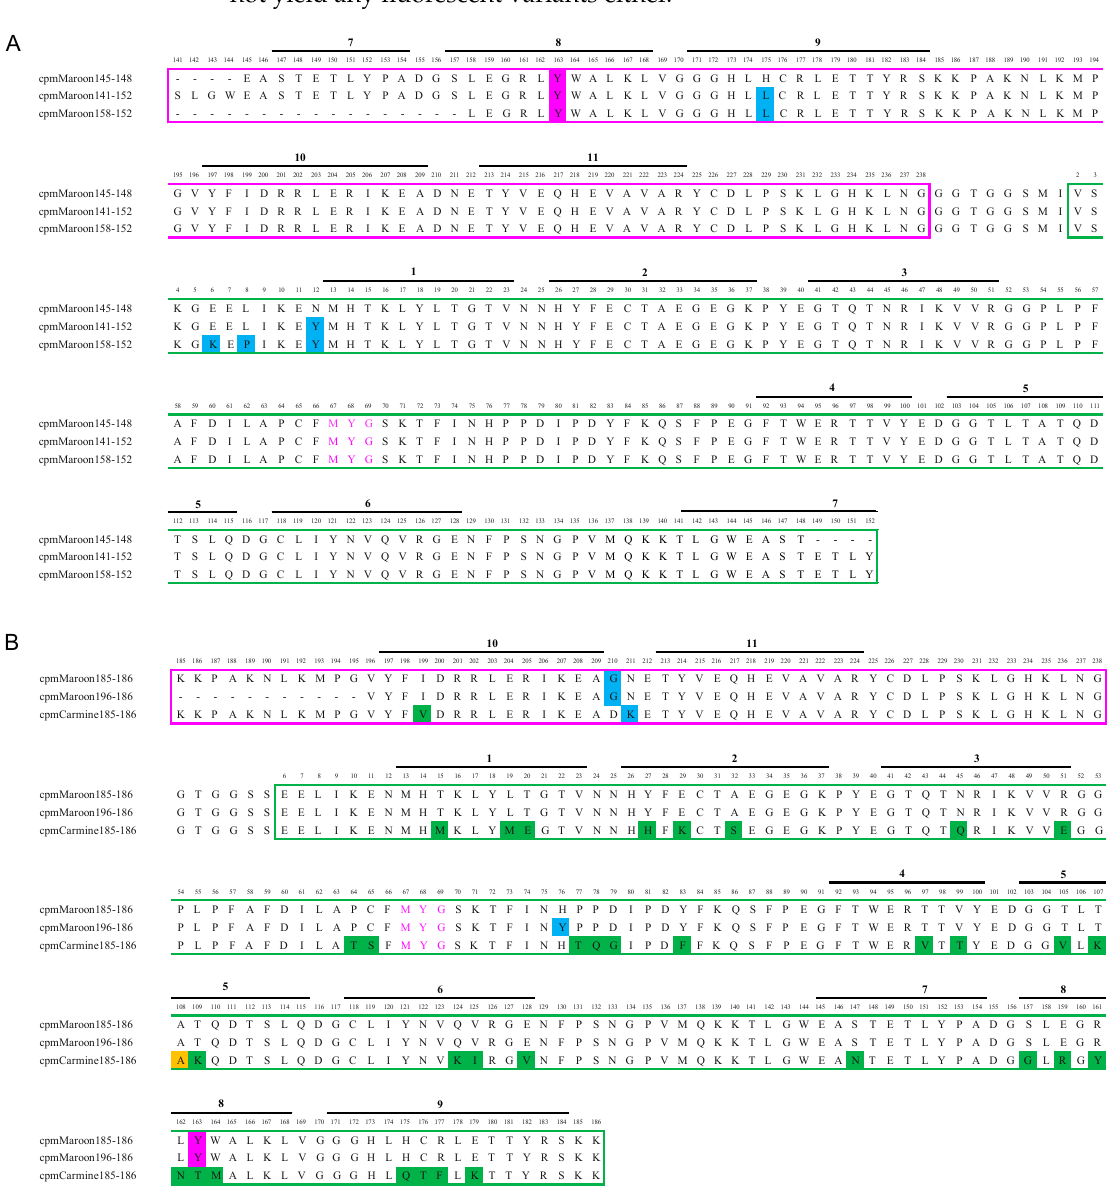
Figure 3. Sequence alignment of circularly permuted mMaroon1 and mCarmine variants, including ( A ) cpmMaroon145-148, cpmMaroon141-152, and cpmMaroon158-152; and ( B ) cpmMaroon185-186, cpmMaroon196-186, and cpmCarmine185-186. The sequences derived from mMaroon1 or mCarmine are in magenta and green boxes. Individual β -strands are denoted by the black lines and numbers above the sequences. The chromophore-forming residues (residues 67–69) are shown in magenta fonts. The mutations from random mutagenesis are shaded in blue. The differences between the original mMaroon1 and mCarmine sequences are shaded in green. One residue in cpCamrmine185-186, initially different from mMaroon1, was mutated to the same residue as mMaroon1 during random mutagenesis, and this residue is shaded in yellow. The D163Y mutation (shaded in magenta) was initially discovered during the engineering of cpmMaroon185-186. Because it was transferable for enhancing the brightness of mMaroon1, it was introduced into all circularly permuted mMaroon1 variants.